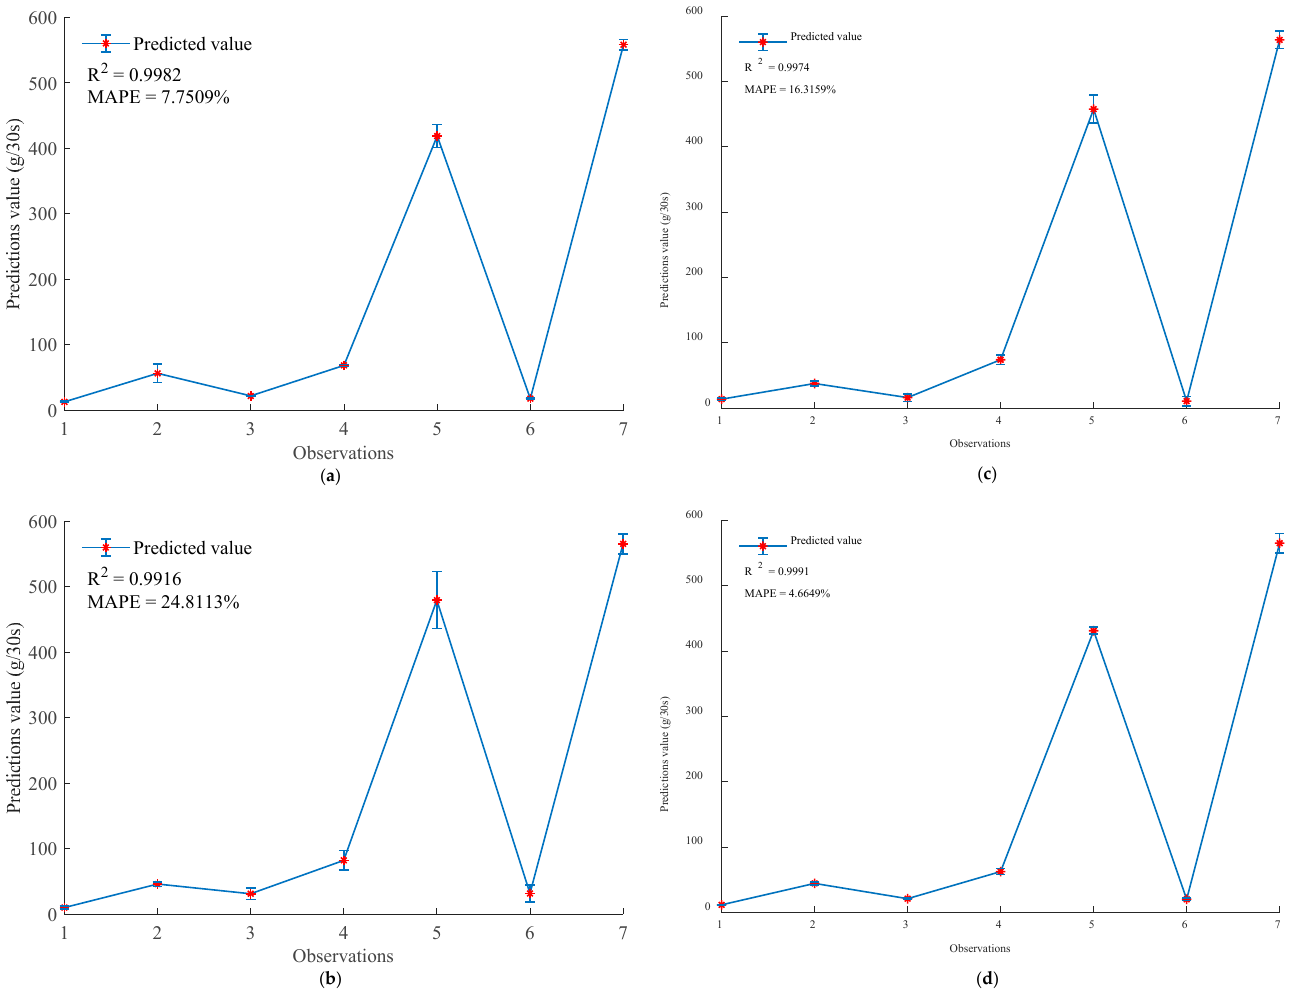
Figure 5. Differences between the experimental data and predicted data for four machine learning algorithms with an opening length range of 6–8 mm: ( a ) BPNN; ( b ) ELM; ( c ) RVM; ( d ) SVM.